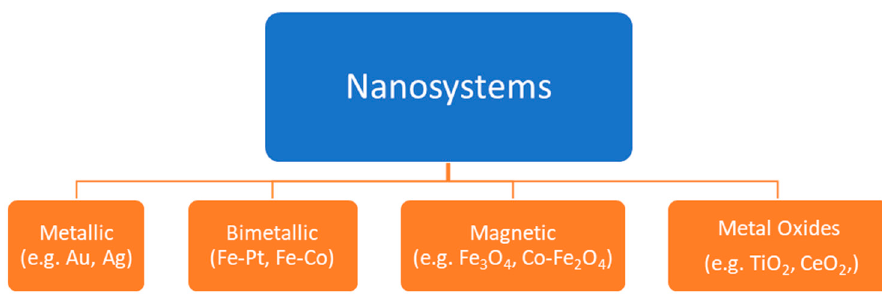
Figure 3. Classification of nanoparticles.